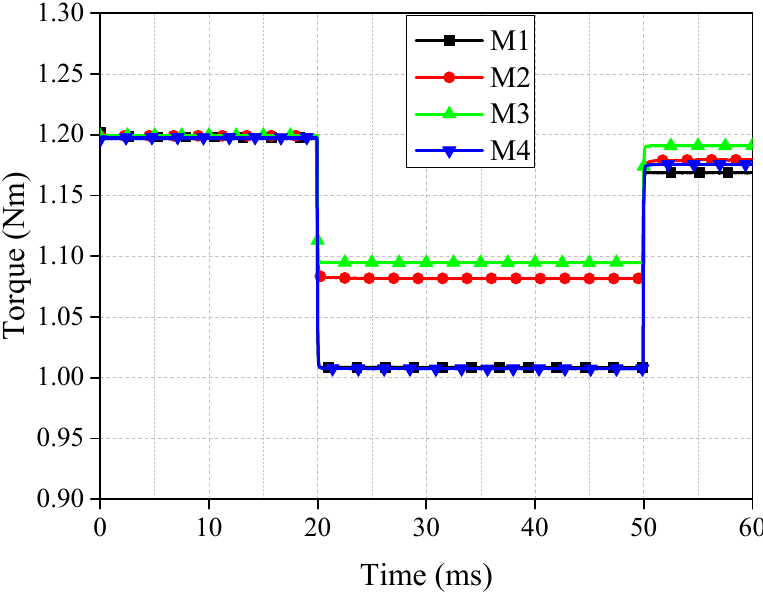
Figure 13. Electromagnetic torque with temperature variation. Table 4. Influence of temperature variation on torque performance.